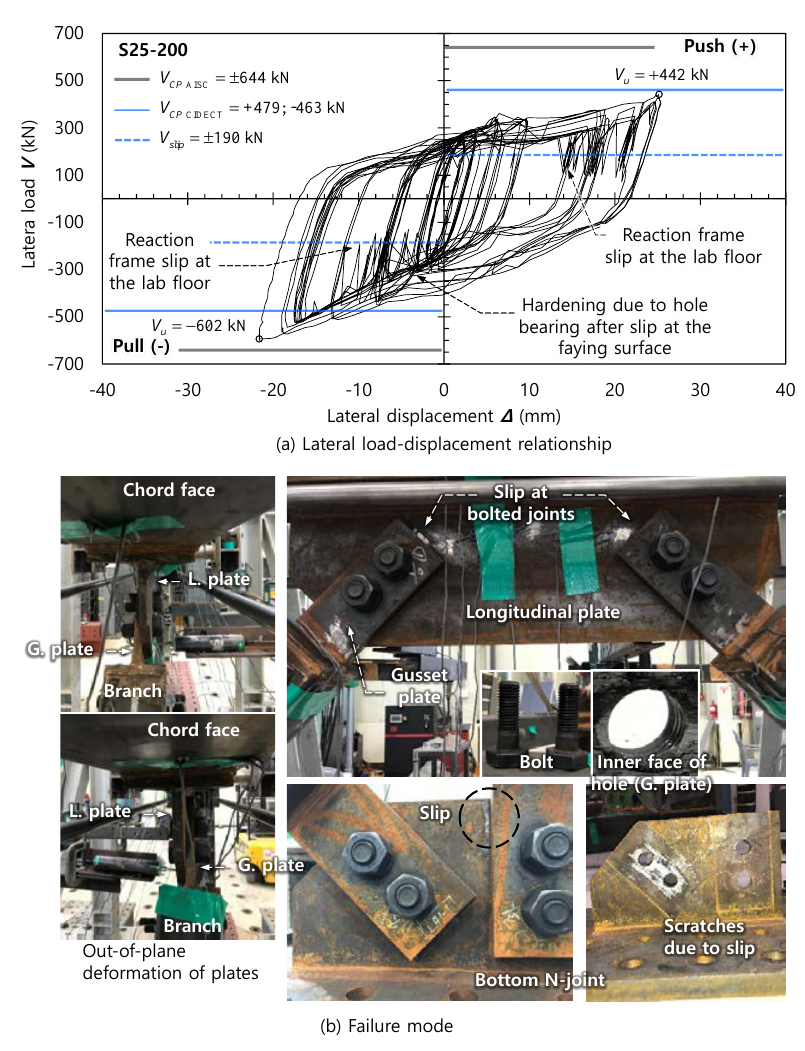
Figure 8. Test results of stiffened plate-to-RHS connection: S25-200: ( a ) Lateral load-displacement